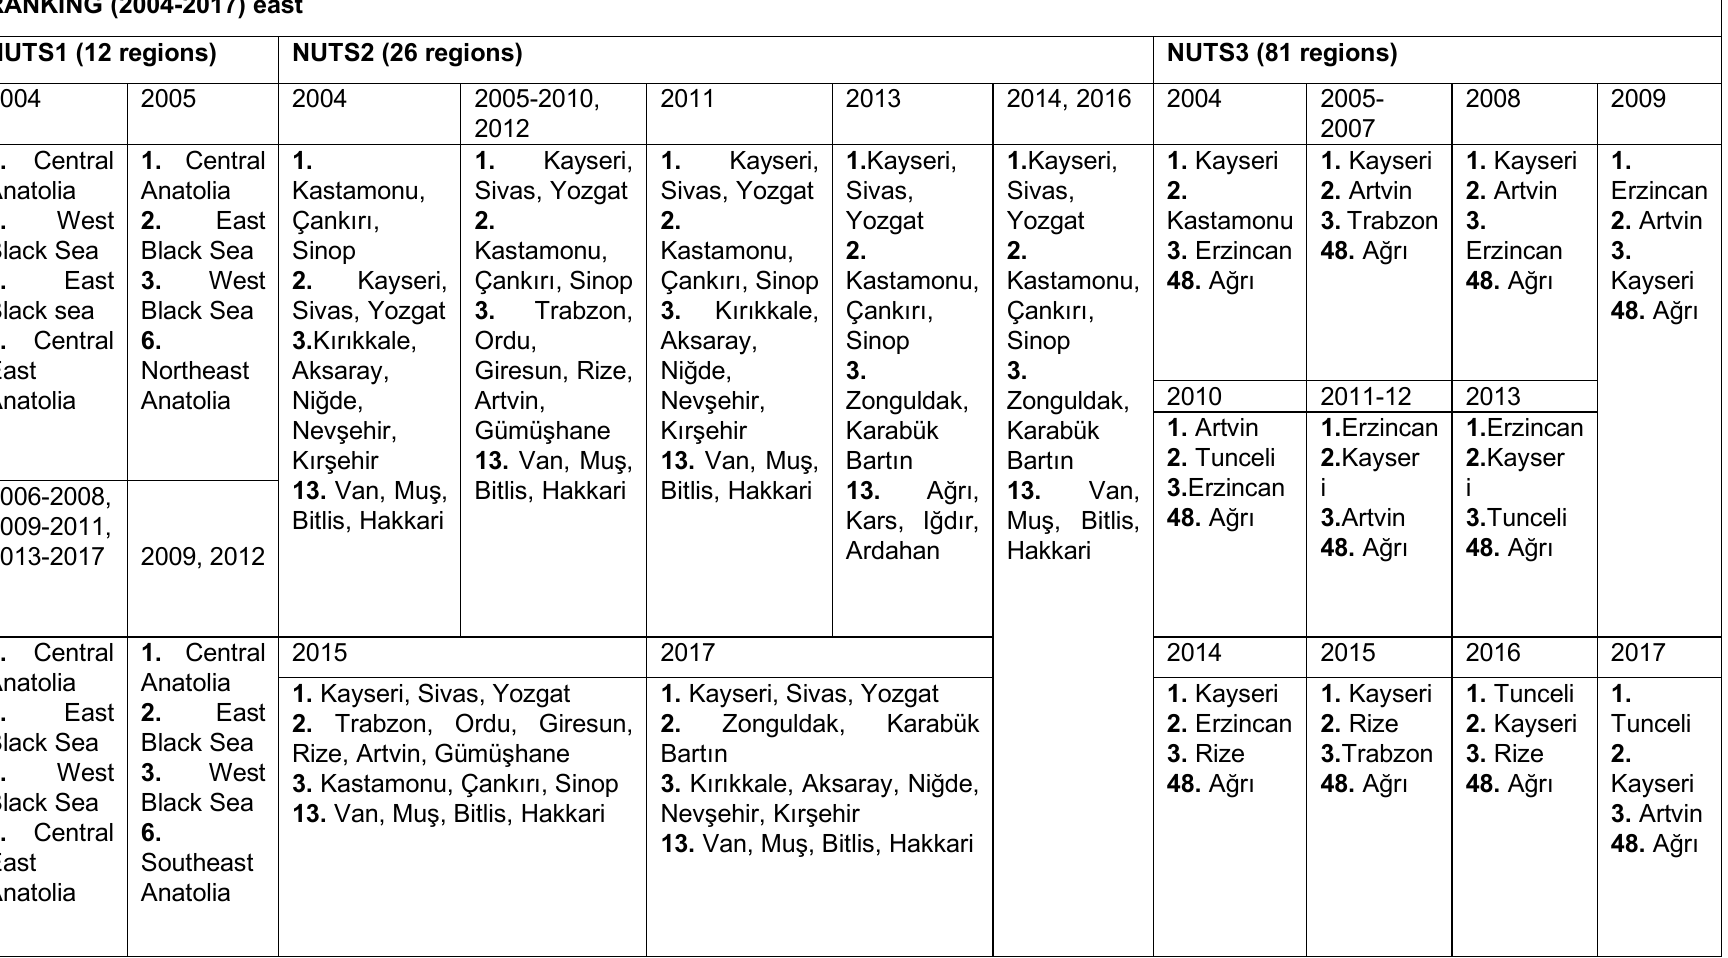
Table C.3: Ranking